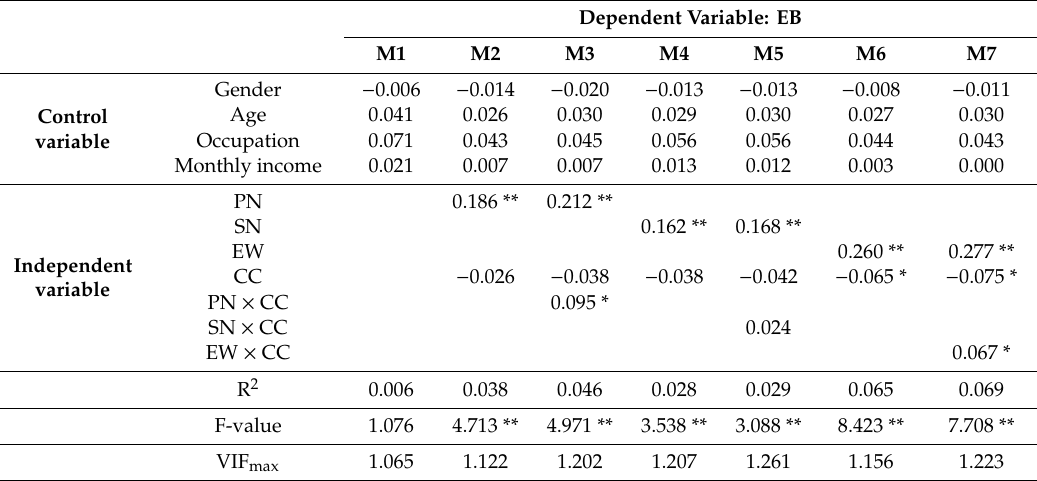
Table 7. Regression results of the moderating e ff ect of cost